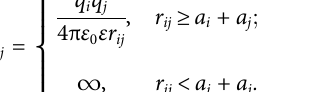
FIGURE 1 | Schematic representation of the model system with two equally and oppositely charged particles in symmetrical multivalent ( z : z ) salt solutions,and x istheseparationbetweenthecentersoftwoparticles.Here|Z| is the absolute charge ofparticles in unit of e, and + z / − z are the valences of symmetrical salt